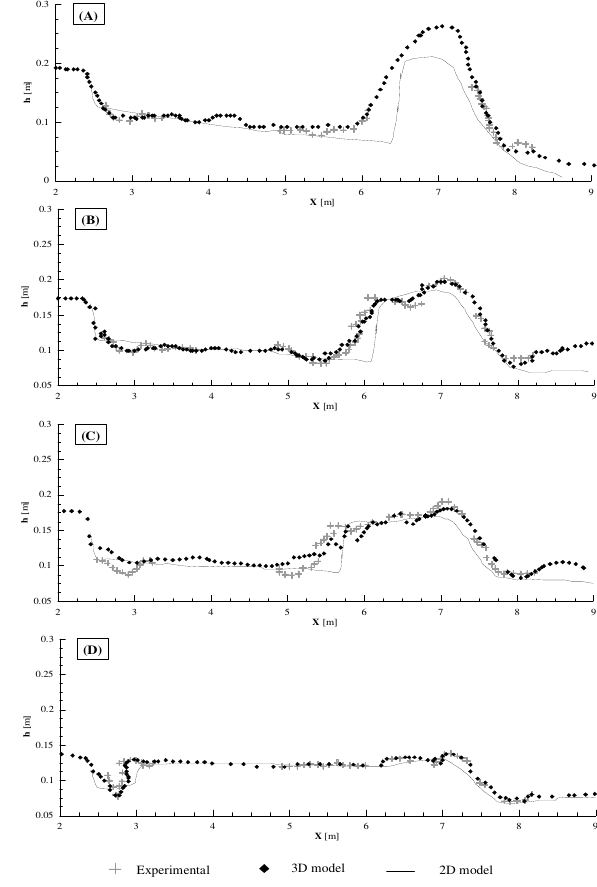
Fig. 15. Dam break over a 90 ◦ bend test. Comparison between computed and experimental free surface profiles along section A-A’ (outer bank) at different times after the failure: 3s (A) , 5s (B) , 7s (C) , 14s (D)